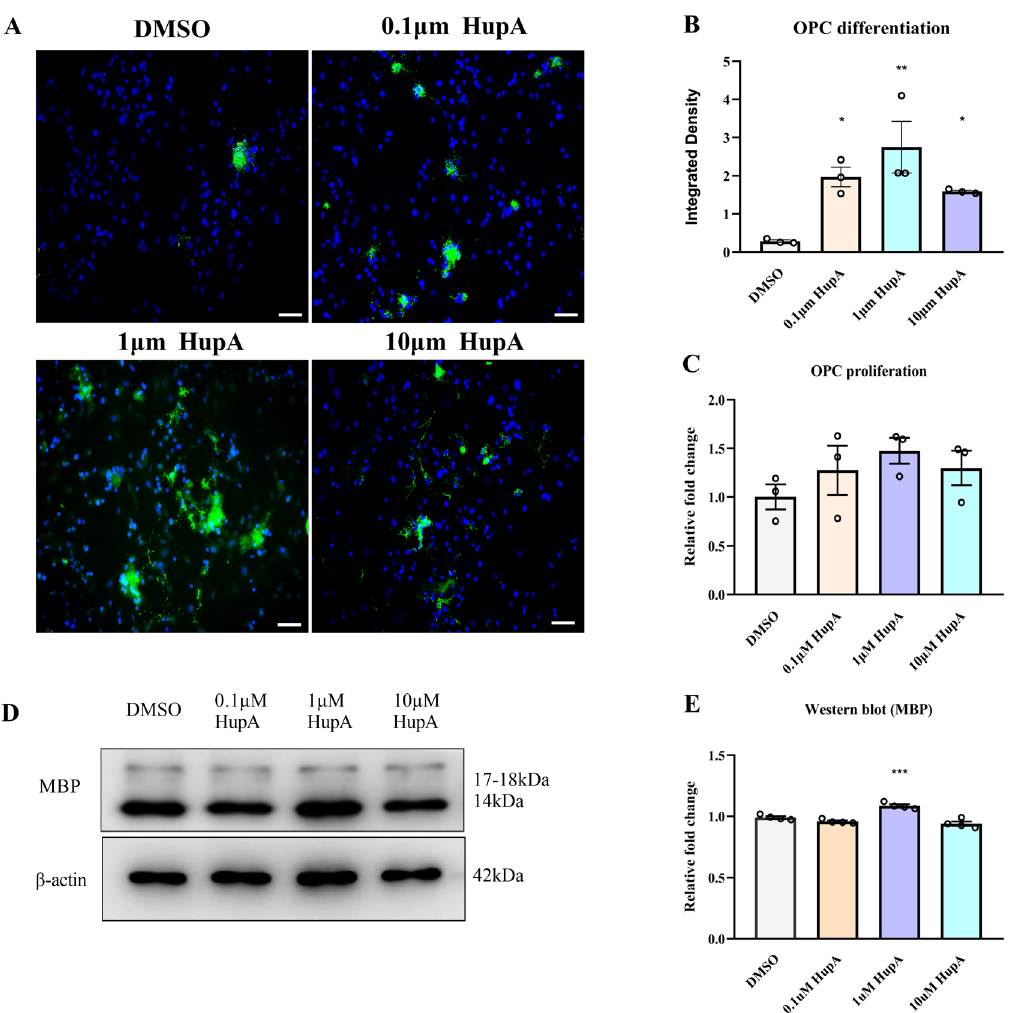
Figure 5. HupA treatment induced OPC differentiation into mature oligodendrocytes in vitro. ( A , B ) ICC with anti-MBP of OPCs cultured in vitro. MBP (green), DAPI (blue), scale bar = 50 µ m. ( C ) The result of OPC proliferation by CTG. ( D , E ) Western blot was used to test MBP expression and analyze the potential effect of drugs on OPC differentiation. The results represent the mean ± SEM (All p values were compared with the control group, * p < 0.05, ** p < 0.01, *** p < 0.001, n = 3/4 mice per group).